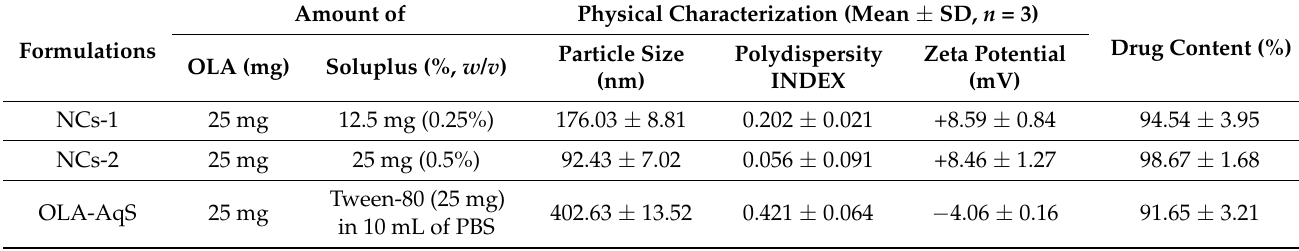
Table 1. Characterization of the OLA-NCs prepared by homogenization followed by probe sonication with two different concentrations of Soluplus ® . Data were represented as mean of three measurements with standard deviation (Mean ± SD, n =